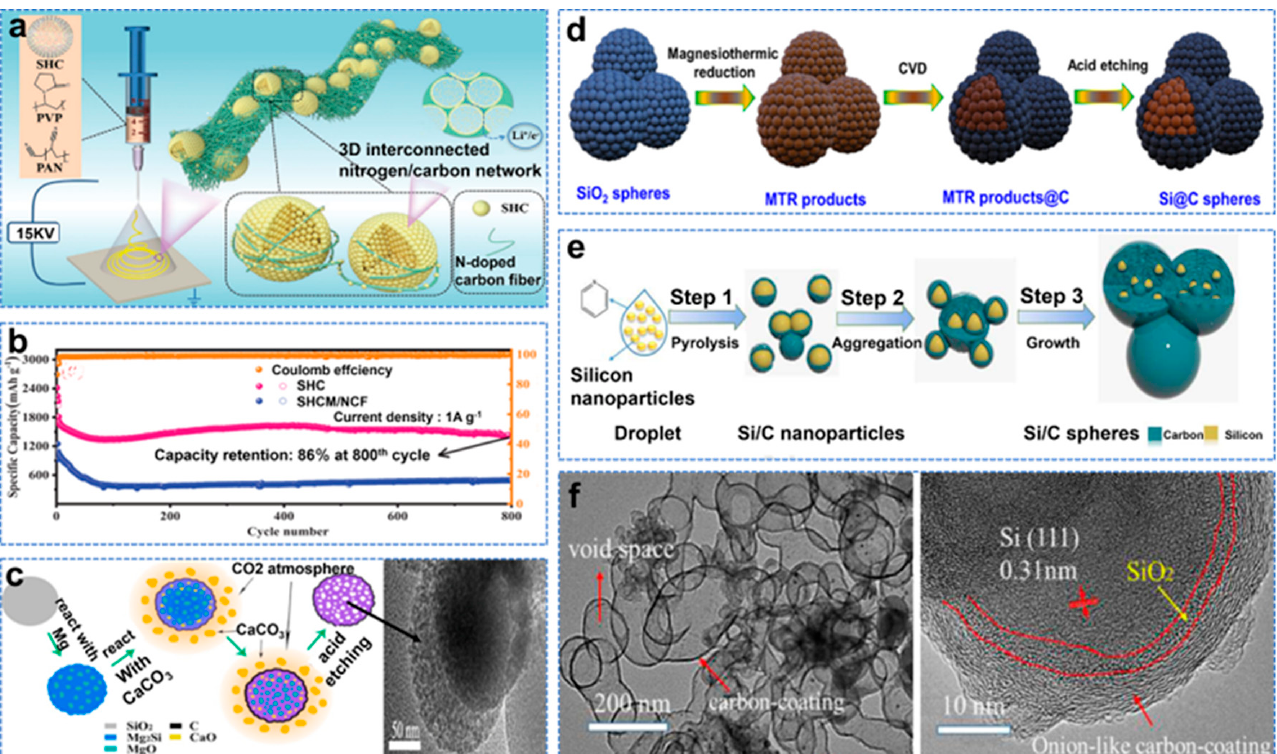
Figure 2. ( a ) Schematic illustration of formation procedure of the SHCM/NCF paper, ( b ) cycling property at 1 A g − 1 [30]. ( c ) Schematic illustration of the reaction from SiO 2 sphere to the final Si@C composite and TEM image of Si@C composite [31]. ( d ) Schematic illustration of the formation process of the composite Si anode [33]. ( e ) Schematic illustration of the formation of onion − like Si/C spheres, ( f ) TEM and HRTEM image of sample [34].